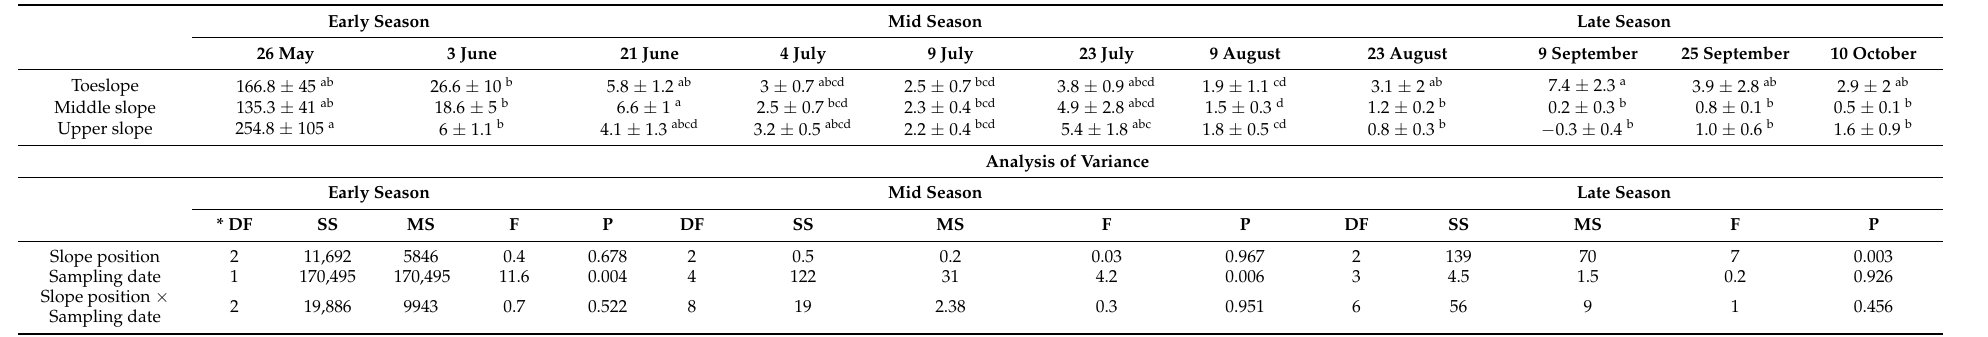
Table 1. Soil N 2 O emissions (g ha − 1 d − 1 ) from different slope positions at different sampling dates during early, mid, and late growing season (2019) from Baggs farm. Means sharing different letters in each season are significantly different from each other (LSD, p < 0.05).